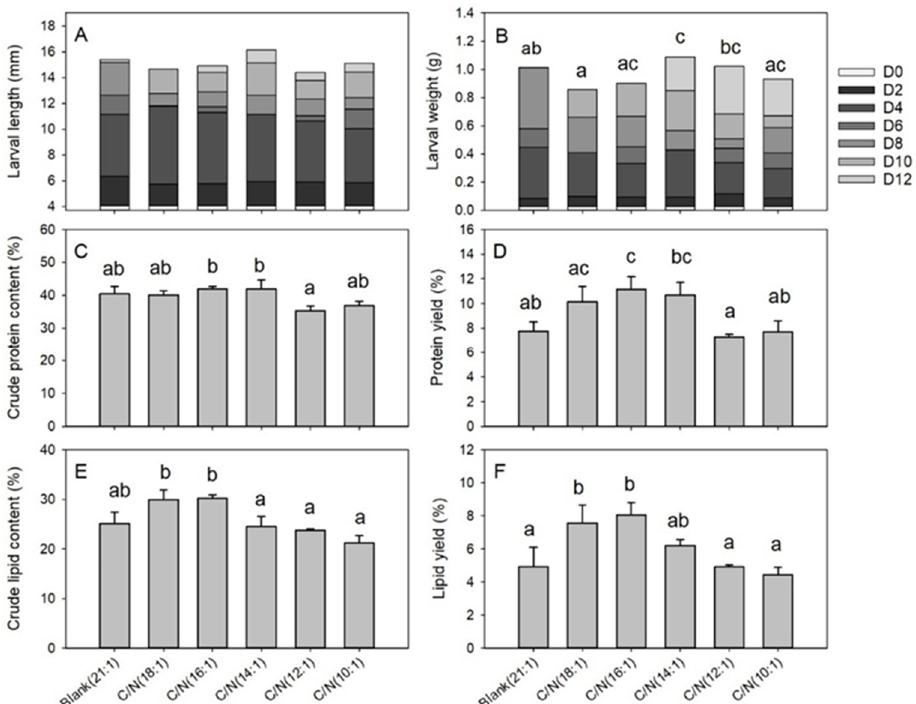
Figure 3. Larval growing and nutrient properties following C/N adjustment in Trial 2. Error bars represent standard deviations ( n = 3). The ( A ) larval length shows no significant differences between groups. The ( B ) larval weight ( p = 0.005), ( C ) crude protein content ( p = 0.011), ( D ) protein yield ( p = 0.003), ( E ) crude lipid content ( p = 0.001), and ( F ) lipid yield ( p = 0.002) are different among groups, and groups with different letters represent significant difference ( p < 0.05).